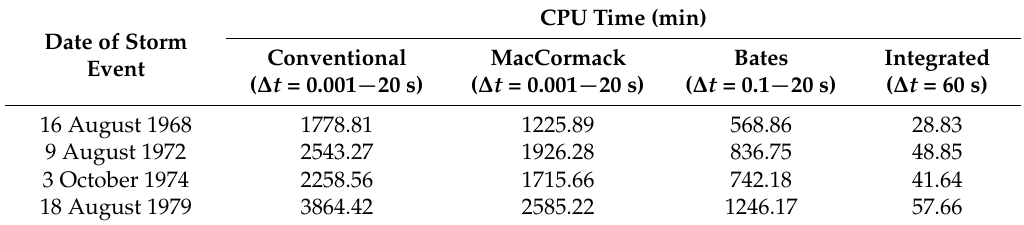
Table 2. Comparison of computational time among different algorithms.